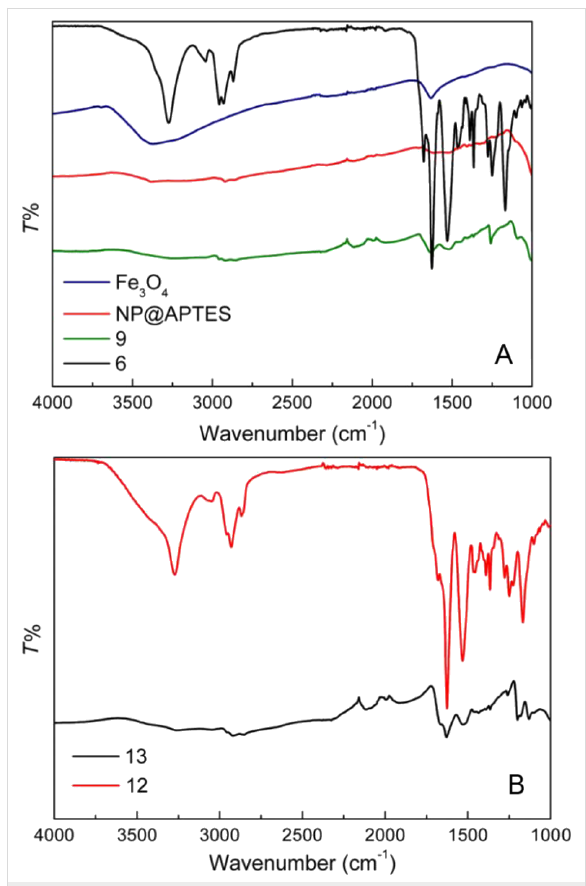
Figure 4: A) Infrared transmission spectra of 9 compared with noncon- jugated 6 and with NP@APTES and magnetite; B) infrared transmis- sion spectra of 13 compared with nonconjugated 12